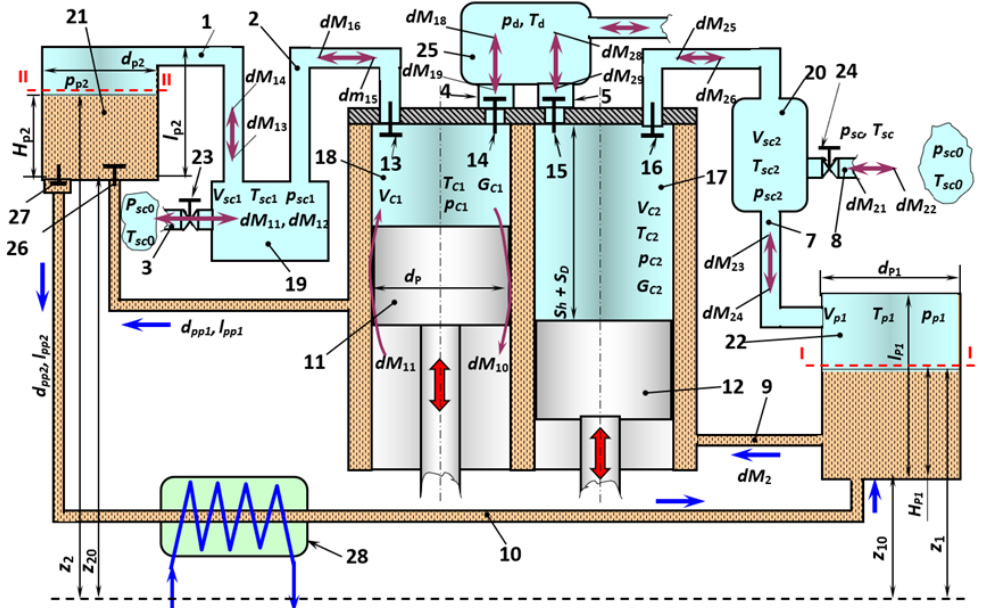
Figure 1. Schematic diagram of a two-cylinder single-stage piston hybrid power machine with liquid movement due to vacuum suction.